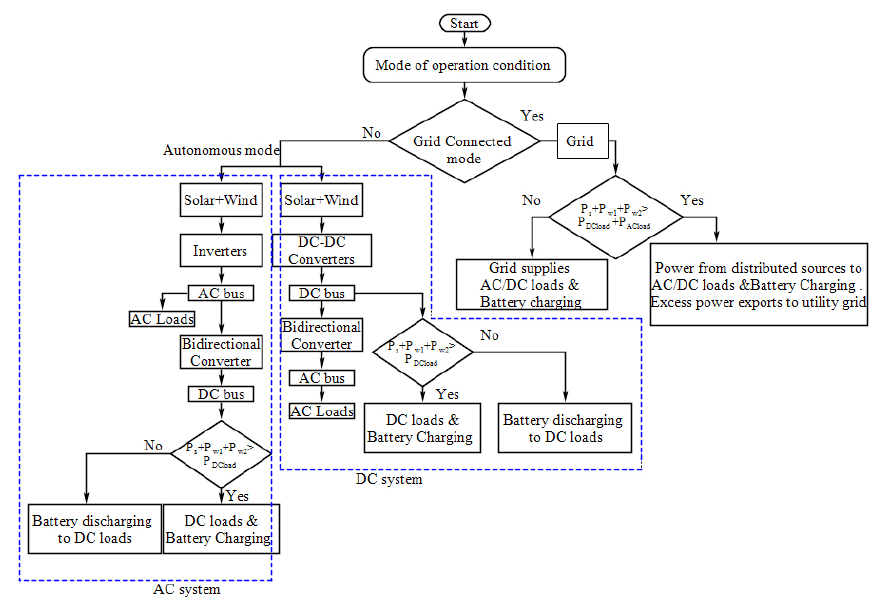
Figure 17. Coordinated control of Micro grid.